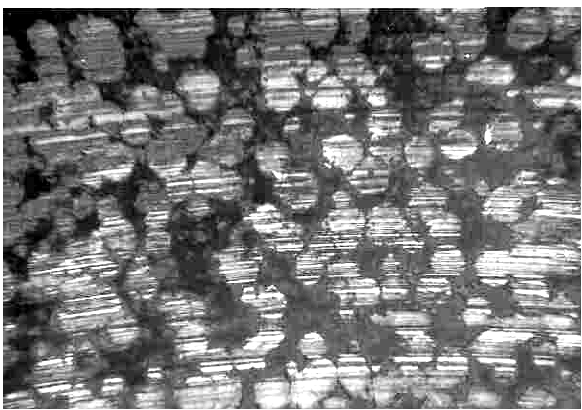
Fig 1. Microstructure of CEC Ni-B after tribotechnical